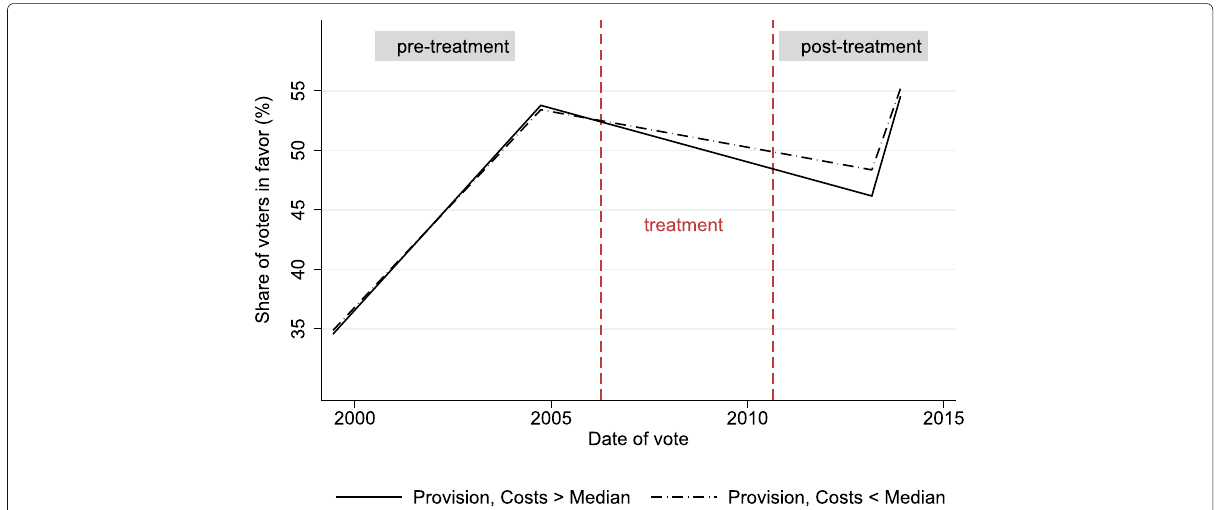
Fig. 7 Vote outcomes of bills promoting maternal employment for the canton of Bern in municipalities with regulation but no provision and municipalities with regulation and provision. The results displayed show population weighted means in vote outcomes for the two groups